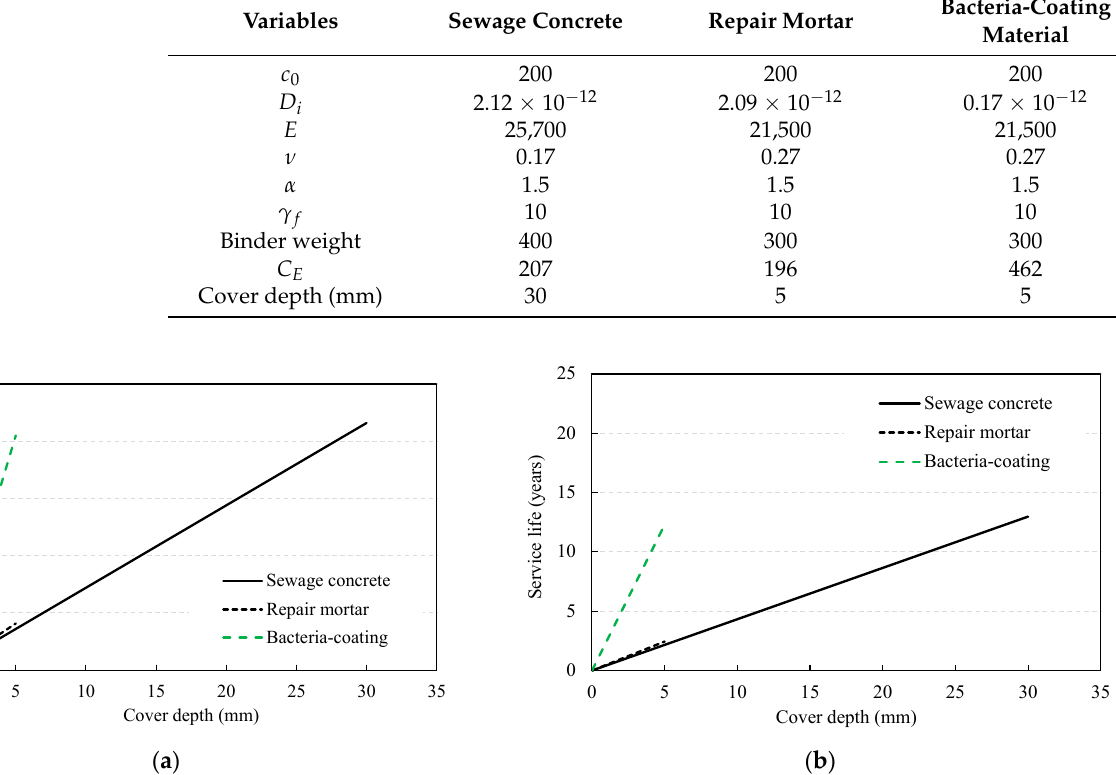
Figure 7. Service life evaluation through deterministic approach: ( a ) sulfate concentration = 120 ppm (normal condition); ( b ) sulfate concentration = 200 ppm (severe condition). Table 7. Service life through deterministic